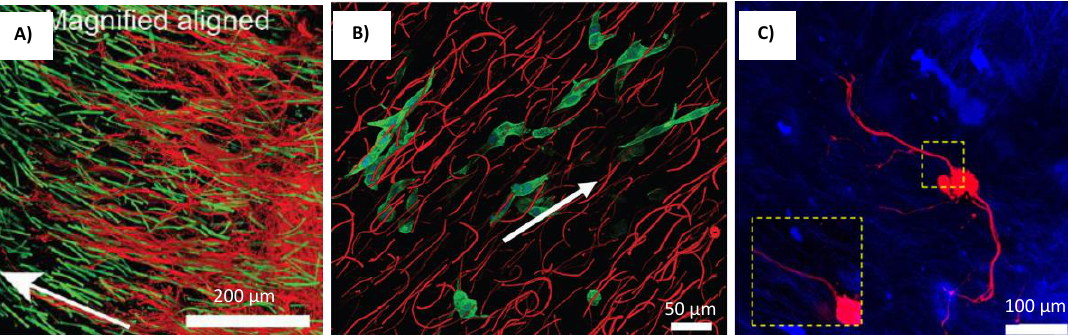
Figure 8. Magnetic orientation method. ( a ) The production of anisogels using a photolithography method. ( b ) Anisogels produced by using a electrospinning and cryo-sectioning. ( c ) Direct applica- tion of iron oxide nanoparticles into injectable collagen hydrogels.